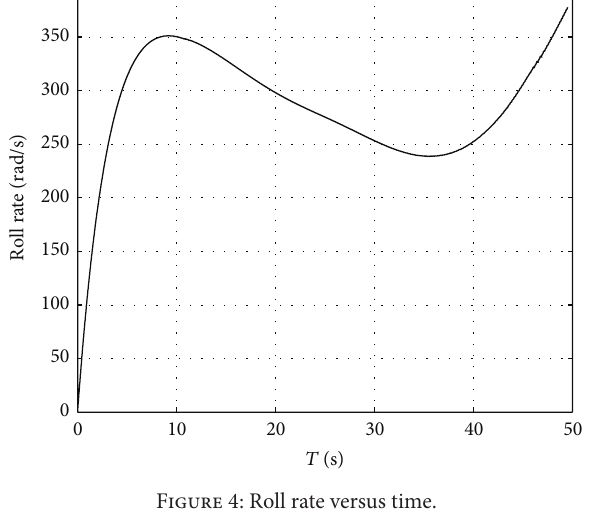
Figure 6: Altitude versus range.